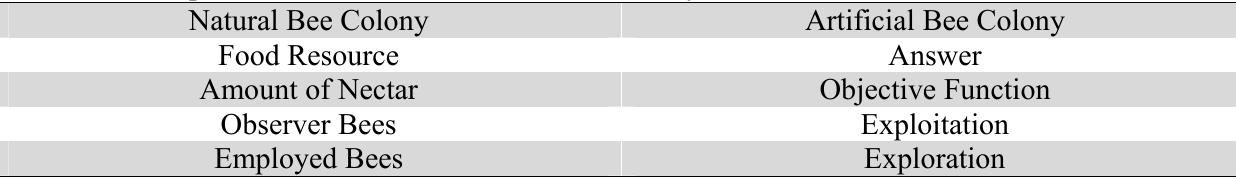
The relationship between natural and artificial bee